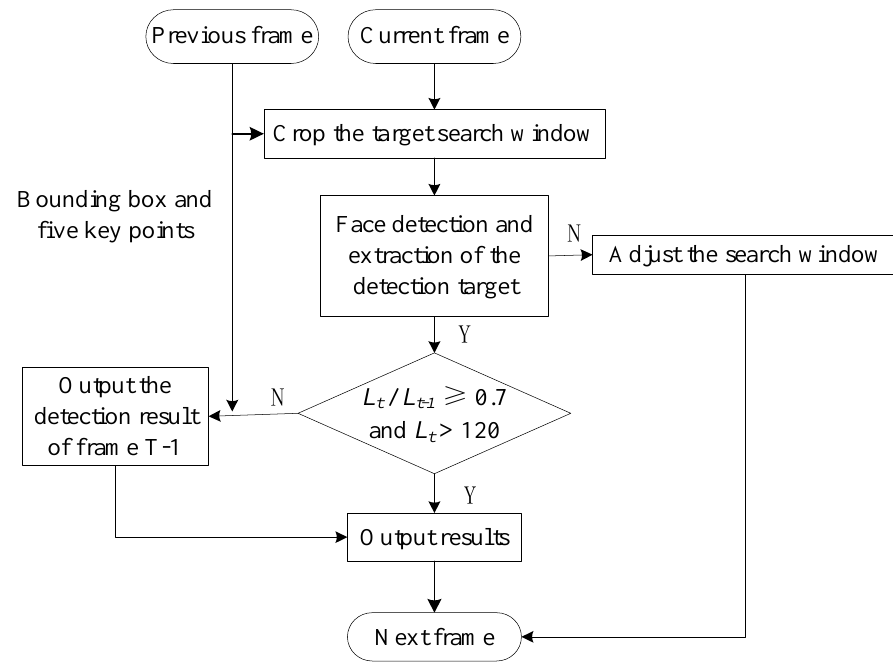
Figure 2. Flowchart of the face tracking and detection algorithm. L t is the side length of the bounding box in current frame; 120 means that the side length of the bounding box should be greater than 120; 0.7 means that the ratio of the side length of the next frame to the side length of the previous frame should be over